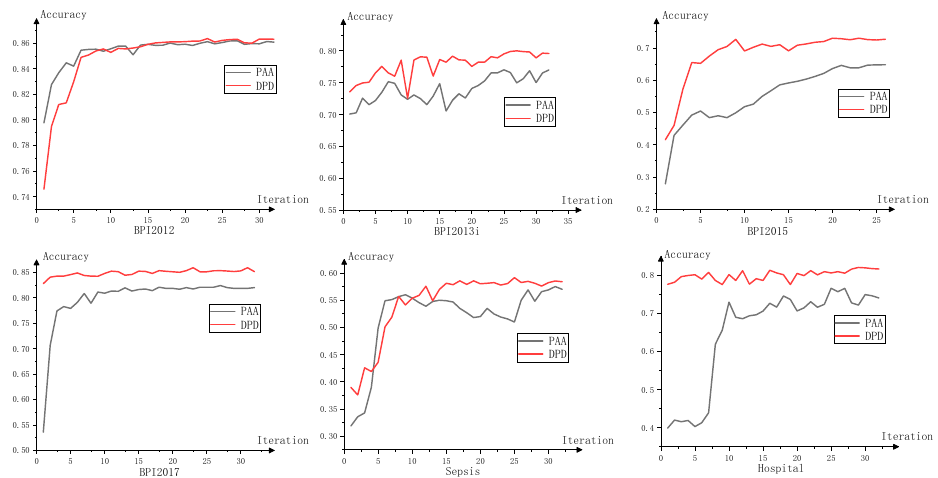
Figure 2. Comparison of the Prediction Accuracy of Business Processes under Different Segmenta- tion Strategies.